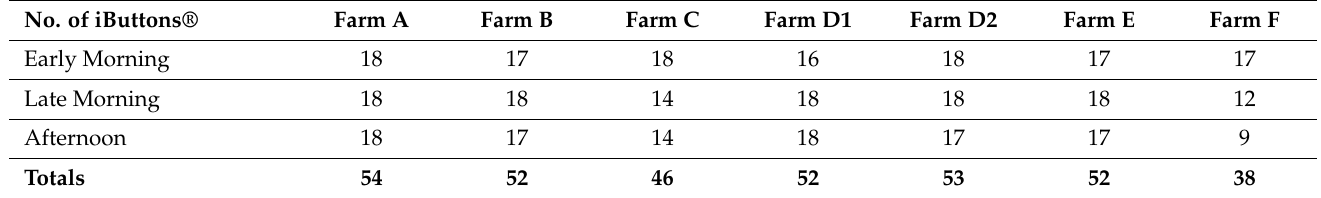
Table 2. Number of iButtons ® retrieved with usable data for each trial conducted on the